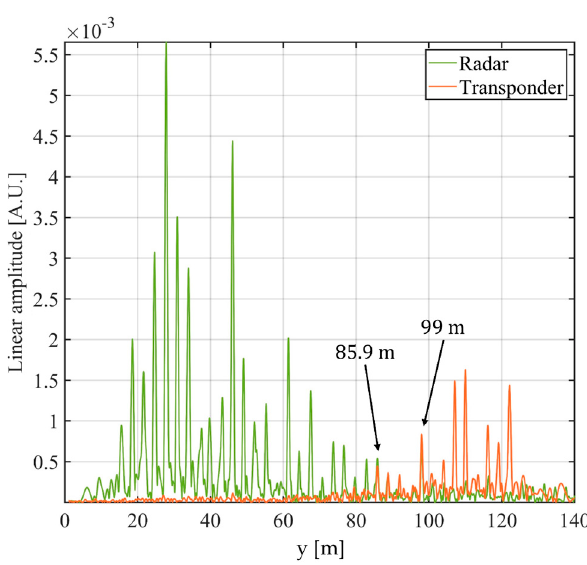
Figure 14. Experimental setup of Indiano Bridge test: ( a ) picture of Indiano Bridge, ( b ) experimental setup.